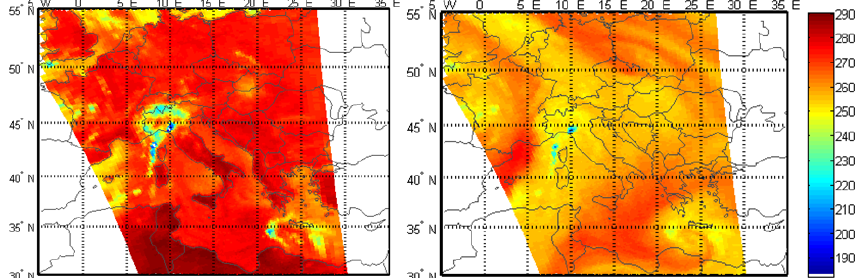
Figure 5. Intense convective precipitation with a flood occurring over the La Spezia area (Italy, 44 ◦ N, 10 ◦ E) on 25 October 2011. AMSU-B (NOAA 19), 11:44UTC: TB (K) at 150GHz (left panel) and TB (K) at 183.31 ± 3GHz (right panel).